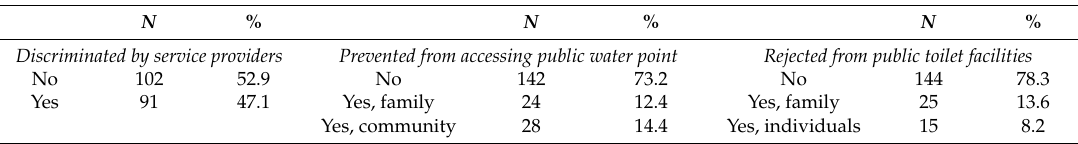
Table A3. Sense of discrimination with regard to service provision among HIV-positive individuals ( N = 199).